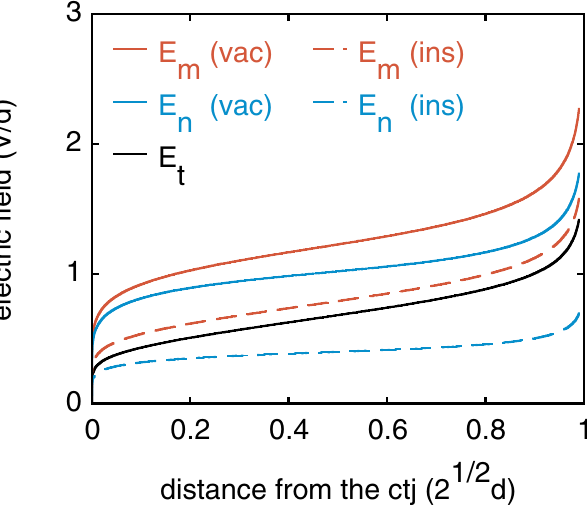
FIG. 3. (Color) Electric fields as a function of distance along the vacuum-insulator interface of the idealized 45 (cid:1) insulator- electrode system outlined in Figs. 1 and 2. The plots assume that the dielectric constant of the insulator " (cid:8) 2 : 55 . The quan- is the absolute value of the electric field normal to the tity E n is the absolute value of the field tangent to the interface, E t (cid:8) (cid:2) E 2 (cid:11) E 2 (cid:4) 1 = 2 . The fields are given in units interface, and E n t m of V=d , where V is the voltage across the insulator and d is the insulator thickness as defined by Fig. 1. The distance from the ctj is given in units of 2 1 = 2 d , the total length of the